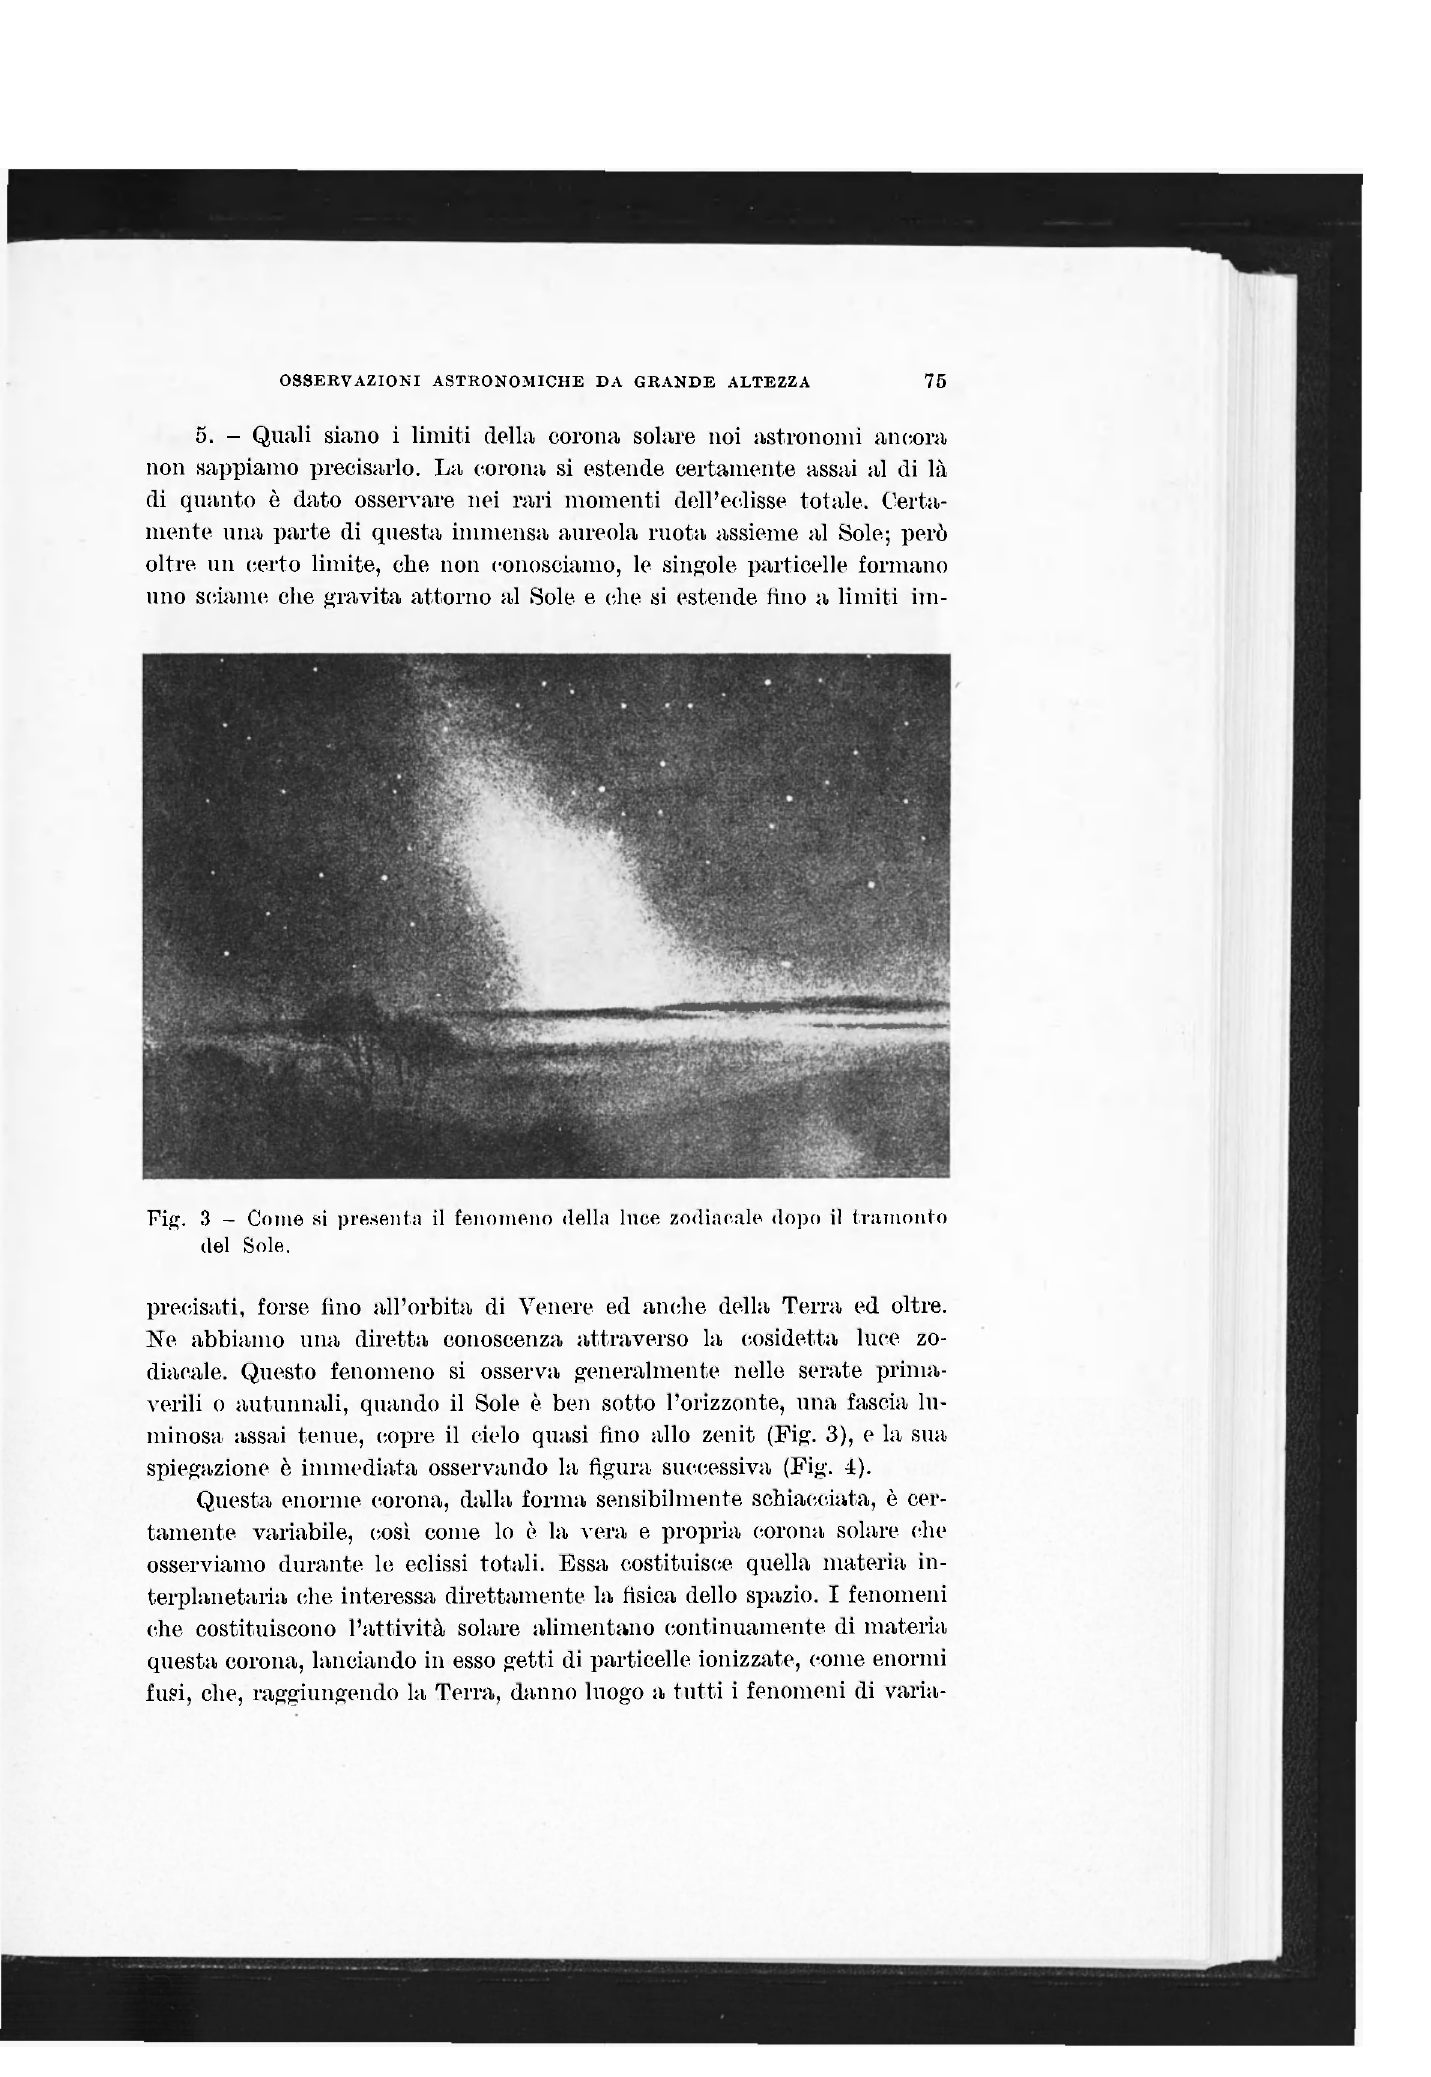
Fig. 3 - Come si presenta il fenomeno della luce zodiacale dopo il tramonto del